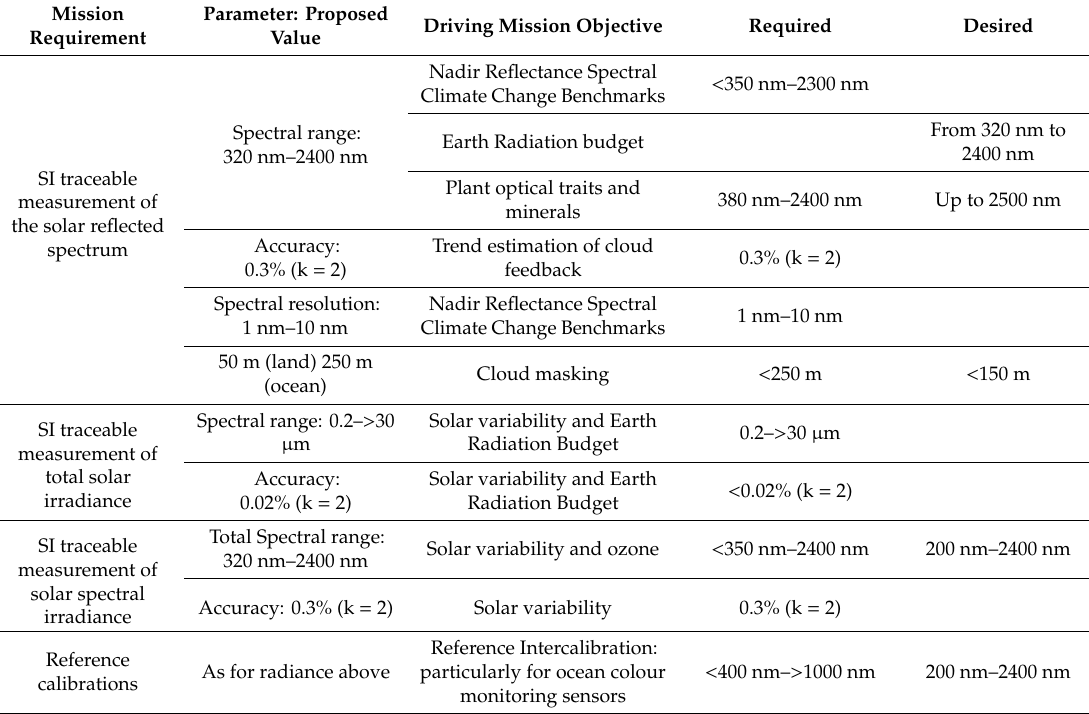
Table 3. Mission requirements for climate benchmark observations of reflected solar radiance, and total and spectral solar irradiance. Spectral resolution is driven by the various climate variables. Accuracy is driven by the climate-benchmarking requirement to detect trends above natural variability.